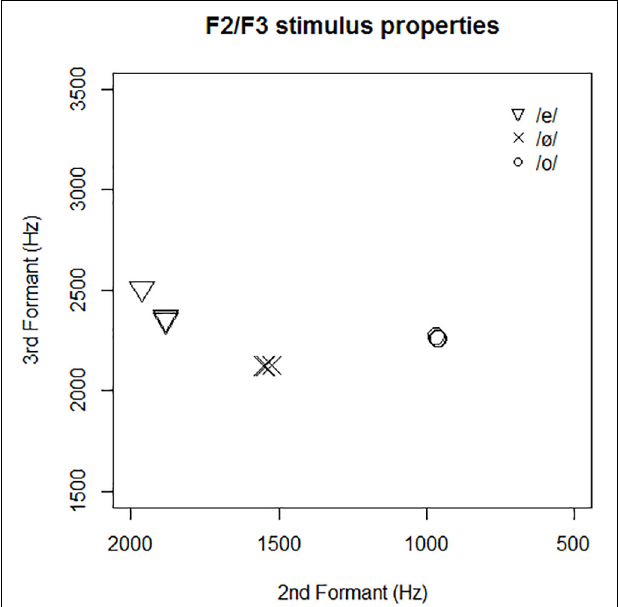
FIGURE 2 | Each of the three tokens per vowel category plotted in F2/F3